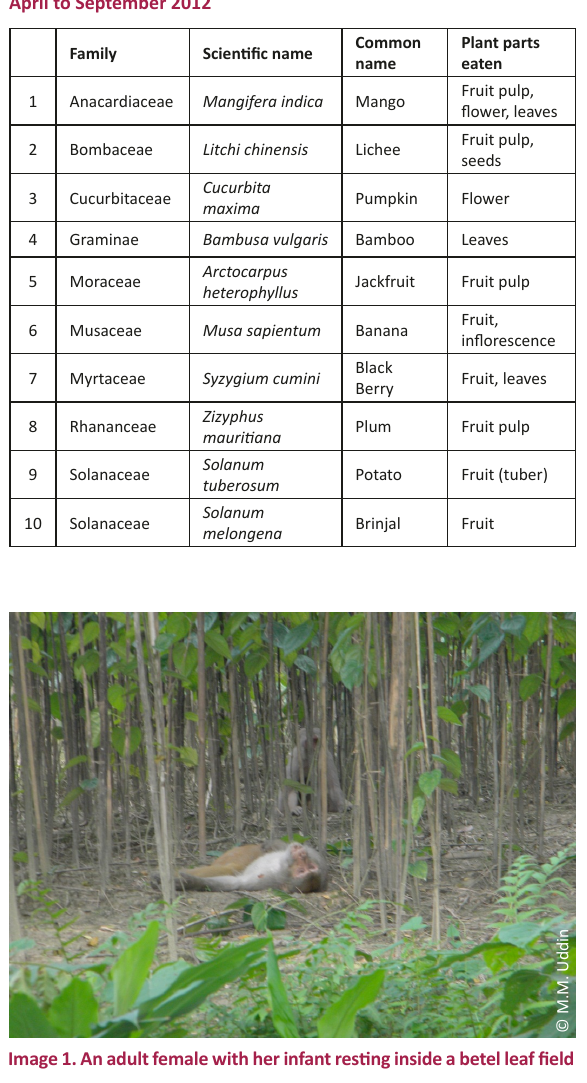
Table 1. Plant parts eaten by Rhesus monkeys at Rampur Village of Monohadi Upazila under Narsingdi District in Bangladesh during